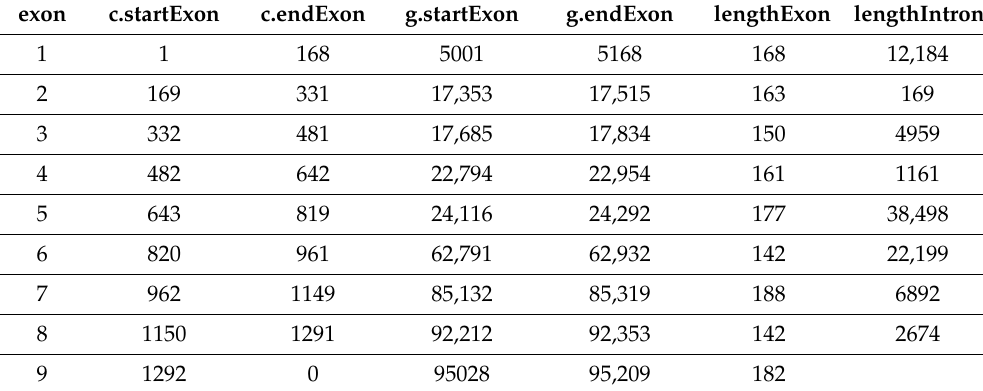
Table 2. List of exon and intron in CYP2C19 sequences